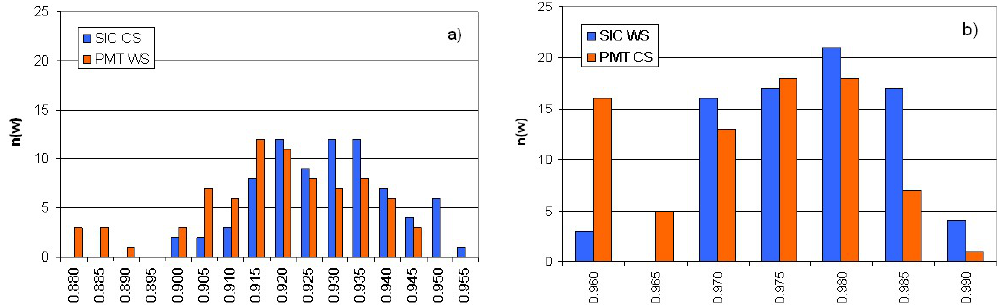
Figure 3. Frequency distribution of w parameter for the two studied areas (SIC and PMT), for warm season (WS) and cold season (CS).